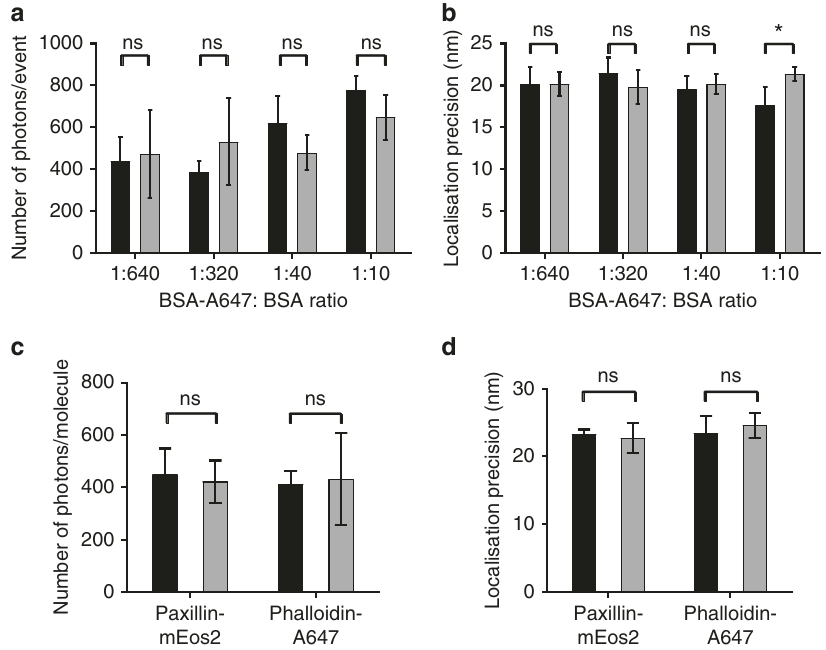
Fig. 1 dSTORM data quality is similar on ITO and glass surfaces. a , b BSA and BSA labelled with Alexa Fluor 647 (BSA-A647) were adsorbed onto ITO (black bars) and glass (grey bars) surfaces at the indicated ratios and imaged with dSTORM under identical conditions. Fluorescent events were identi fi ed and grouped as described in the Methods to extract the number of photons ( a ) and the localisation precision ( b ) as a function of labelled BSA. c , d NIH- 3T3-cells-expressing paxillin fused to mEos2 were plated onto ITO (black bars) and glass (grey bars) surfaces and stained with phalloidin conjugated to Alexa Fluor 647. PALM and dSTORM images were recorded under identical imaging conditions for both surfaces and the number of photons per molecule ( c ) and localisation precision ( d ) calculated. Bars and error bars in a − d indicate average and standard deviation, respectively, of n = 5 ( a , b ) and n = 4 ( c , d ) independent experiments; ns not signi fi cant; * P ≤ 0.05 (two-tailed t test assuming equal